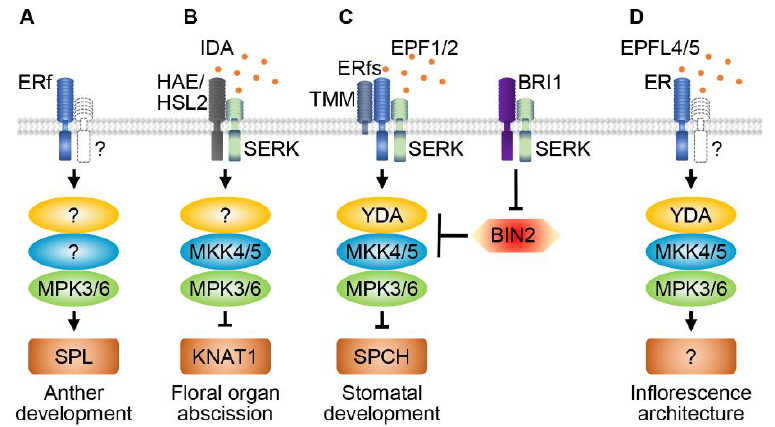
Figure 3. RLKs and MAPK cascades regulate reproductive and stomatal development. ERECTA family (ERf) members and MPK3 / 6 modulate anther development via activating the transcription factor SPOROCYTELESS (SPL) ( A ). HAESA / HAESA-like 2 (HAE / HSL2) and coreceptor SERKs perceive the INFLORESCENCE DEFICIENT IN ABSCISSION (IDA) peptide signal to control floral organ abscission by activating MKK4 / 5 and MPK3 / 6 ( B ). ERf, TOO MANY MOUTH (TMM) and SERKs form a receptor complex to sense the EPIDERMAL PATTERNING FACTOR 1 / 2 (EPF1 / 2) peptide ligands to control stomatal development and pattern via the YDA-MKK4 / 5-MPK3 / 6 cascade. BRASSINOSTEROID-INSENSITIVE 2 (BIN2) functions downstream of BRASSINOSTEROID INSENSITIVE 1 (BRI1) to repress the activity of YDA and MKK4 / 5 in controlling stomatal development ( C ). ER perceives the EPF-LIKE 4 / 5 (EPFL4 / 5) peptide signals to regulate inflorescence architecture via the YDA-MKK4 / 5-MPK3 / 6 cascade ( D ). ? represents the unknown RLK, MAPK or transcription factor.